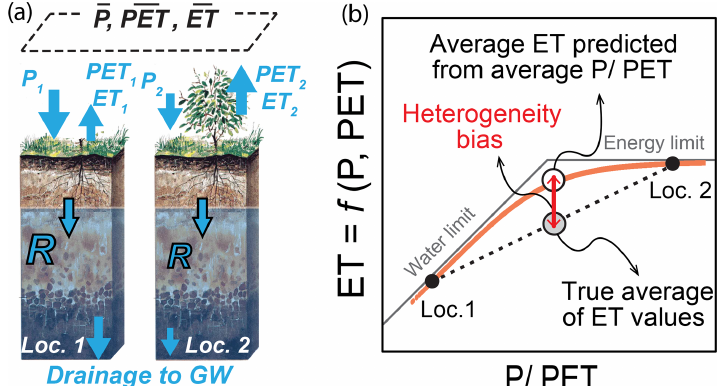
Figure 1. Heterogeneity bias in a hypothetical two-column model in the Budyko framework. The true average ET of the columns (gray circle) lies below the curve and is less than the average ET estimated from the average P/ PET of the two columns (open circle). The heterogeneity bias depends on the curvature of the function and the spread of its inputs. Both panels are adapted from Rouholahnejad Freund and Kirchner (2017). Location: